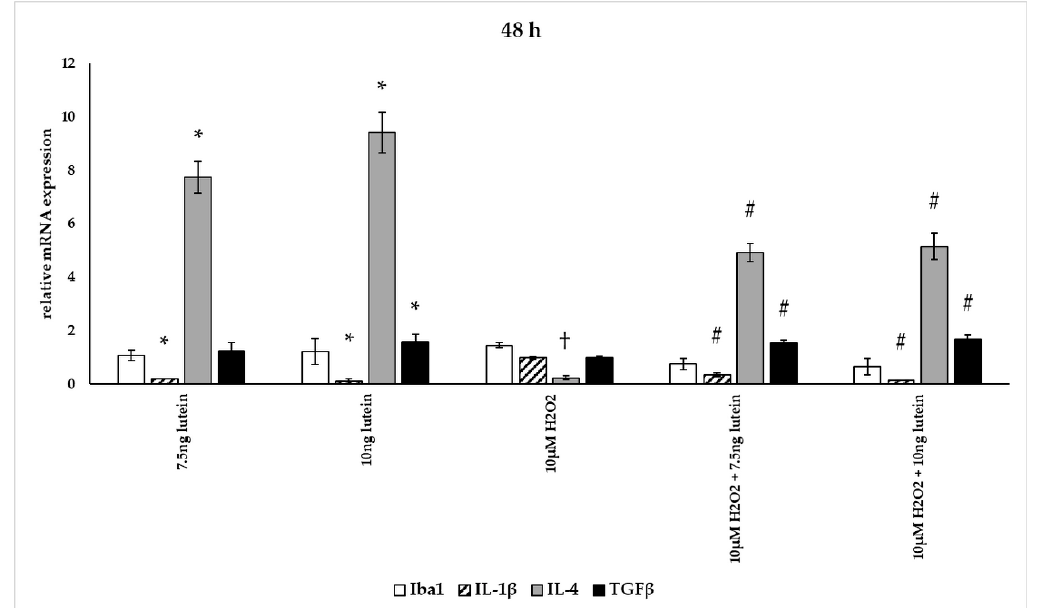
Figure 13. Effects of lutein and H 2 O 2 on Iba1, IL-1 β , IL-4 and TGF β mRNA expression at 24 h. The columns represent the mean values, and error bars indicate the standard deviation (SD) of three independent experiments ( n = 3), each performed in triplicate, and are presented relative to own control cells. * indicates statistical significance of lutein treatments versus controls; † indicates statistical significance of H 2 O 2 treated cells compared to controls; # indicates statistical significance of combined (lutein with H 2 O 2 ) treatments compared to H 2 O 2 treatments; the level of significance was p < 0.05. Real-time PCR was performed with the SYBR green protocol using gene-specific primers. β -actin was used as house-keeping gene for the normalization. The relative expression of controls was regarded as 1.